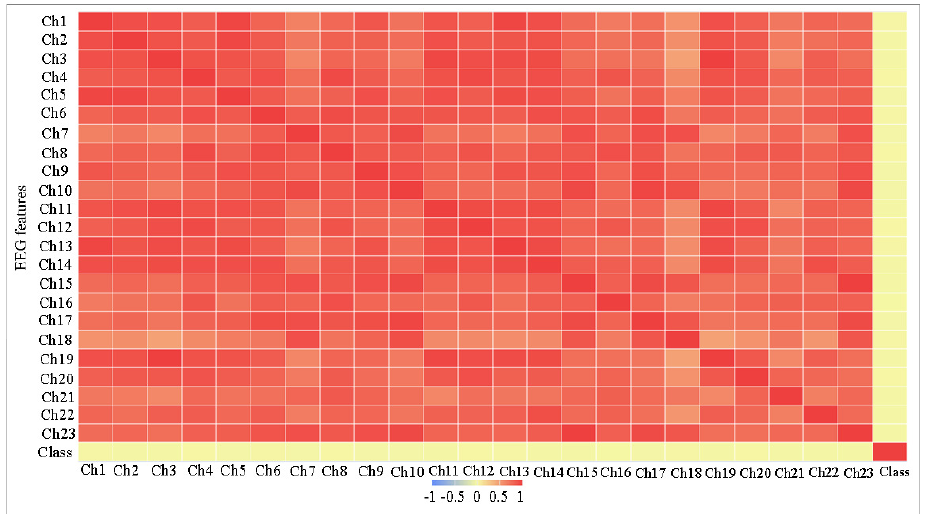
Figure 3. The Correlation matrix among all features of CHB-MIT dataset. Table 2. The Correlation between features and target class of CHB-MIT dataset.